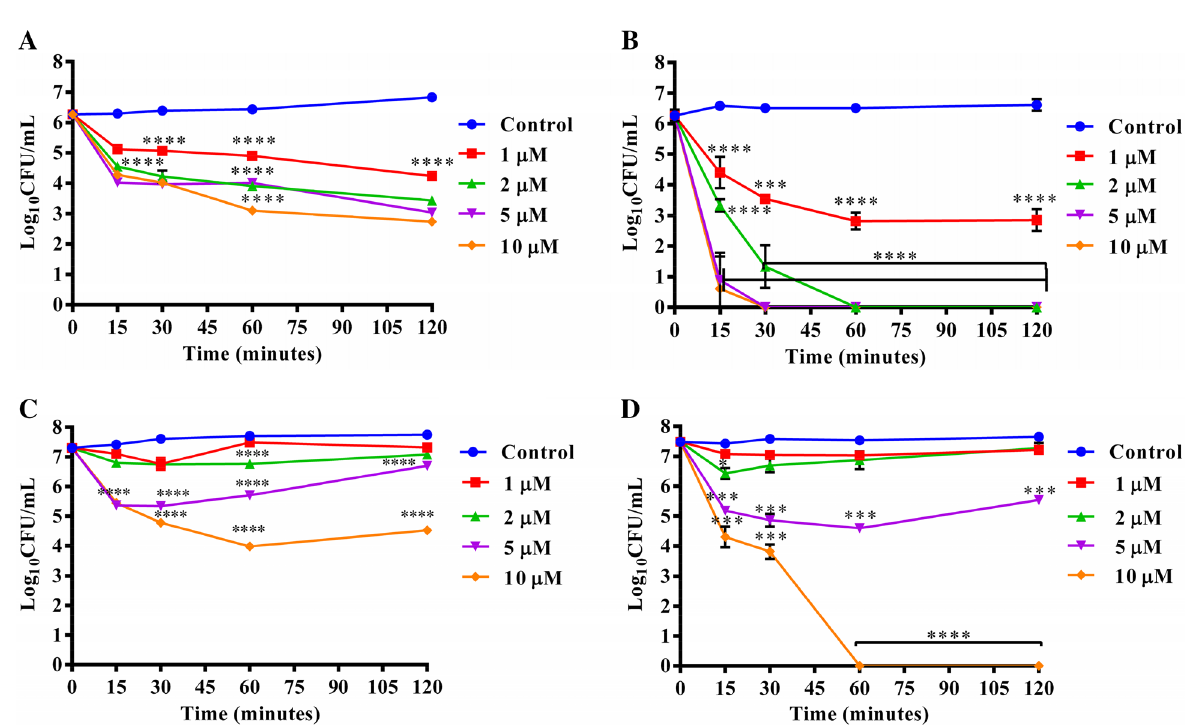
Figure 2. Effect of higher bacterial cell densities of logarithmic phase E. coli on the killing kinetics of ( A ) KKA- MSH and ( B ) KKK-MSH against 10 6 CFU/mL, and ( C ) KKA-MSH and ( D ) KKK-MSH against 10 7 CFU/mL at different concentrations of 1 µM, 2 µM, 5 µM, and 10 µM. Each data point denotes the representative values (average ± SE) from the experiment performed on three independent days **** P < 0.0001, compared to untreated